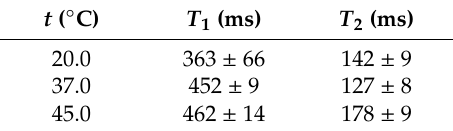
Table 3. T 1 and T 2 relaxation parameters determined at 9.4 T magnetic field; presented as values ± fid-based SD. Fitting curves can be seen in Figure S7 and S8; all were fitted with R 2 ≥